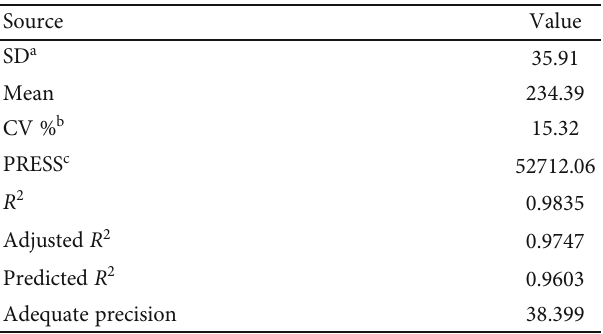
a Standard deviation. b Percentage of coe ffi cient of variation. c Predicted residual sum of